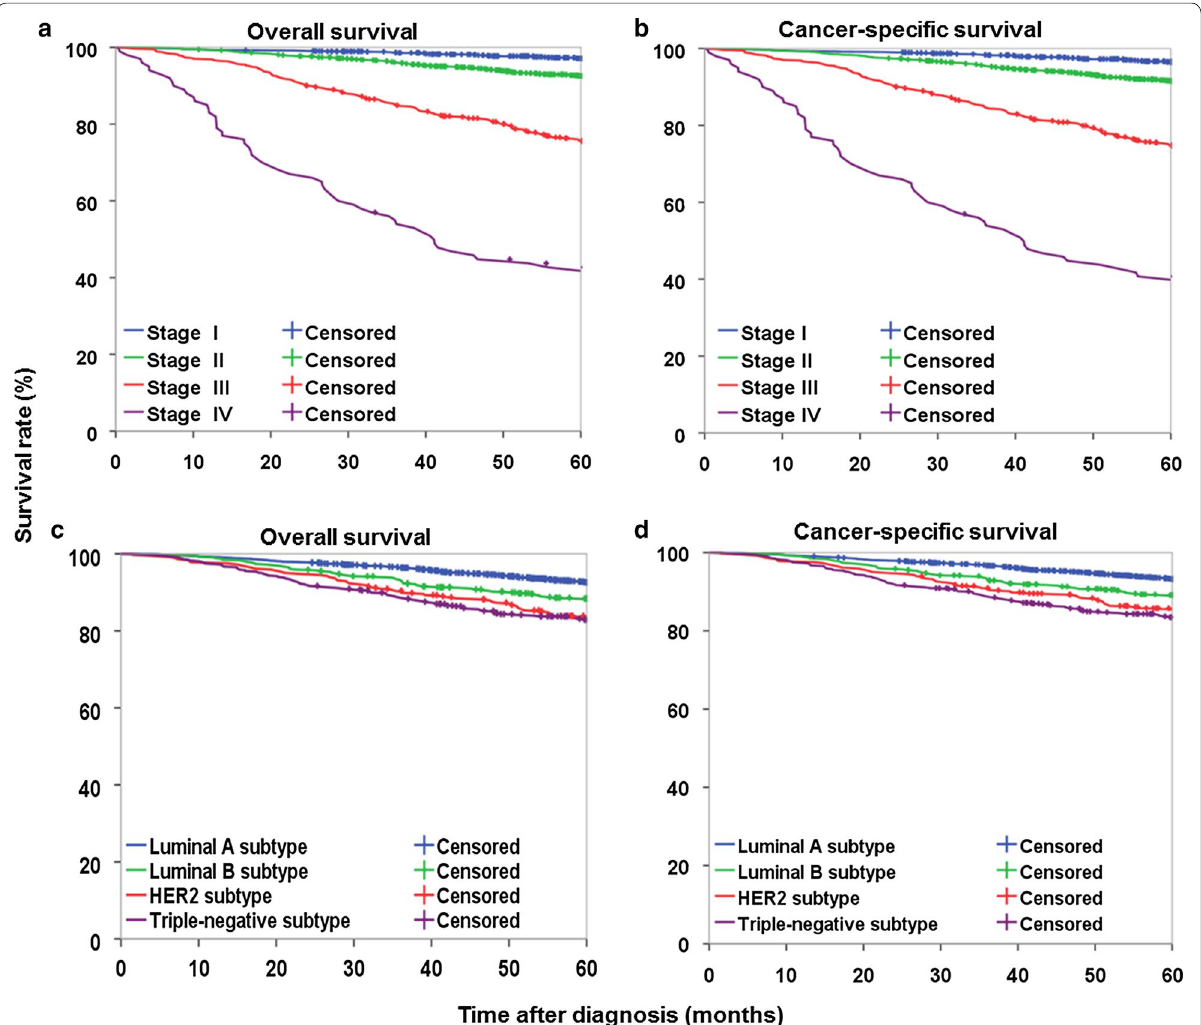
Fig. 1 Survival curves of female patients with breast cancer at different stages at diagnosis or of different molecular subtypes. a Overall survival curves of patients according to tumor stage. b Cancer-specific survival curves of patients according to tumor stage. c Overall survival curves of patients according to molecular subtype. d Cancer-specific survival curves of patients according to molecular subtype. Log-rank test showed signifi- cant differences in survival among groups in the four panels (all P <